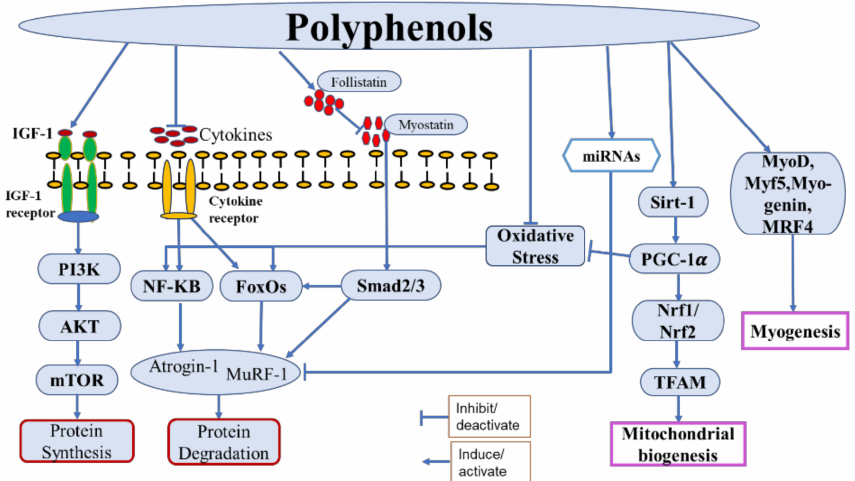
Figure 2. Schematic illustration of the possible representative pathways of polyphenols action in the treatment of skeletal muscle disorders and improvement of muscle